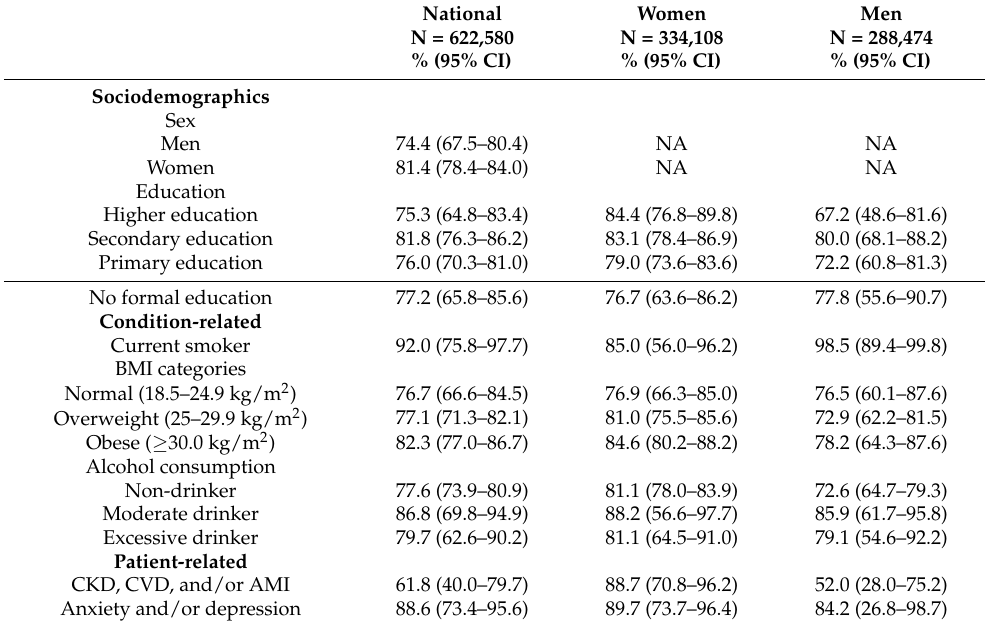
Table 3. Prevalence of low-moderate medication adherence in participants with diagnosed hyperten- sion aged 18 years old or more, stratified by sex and selected